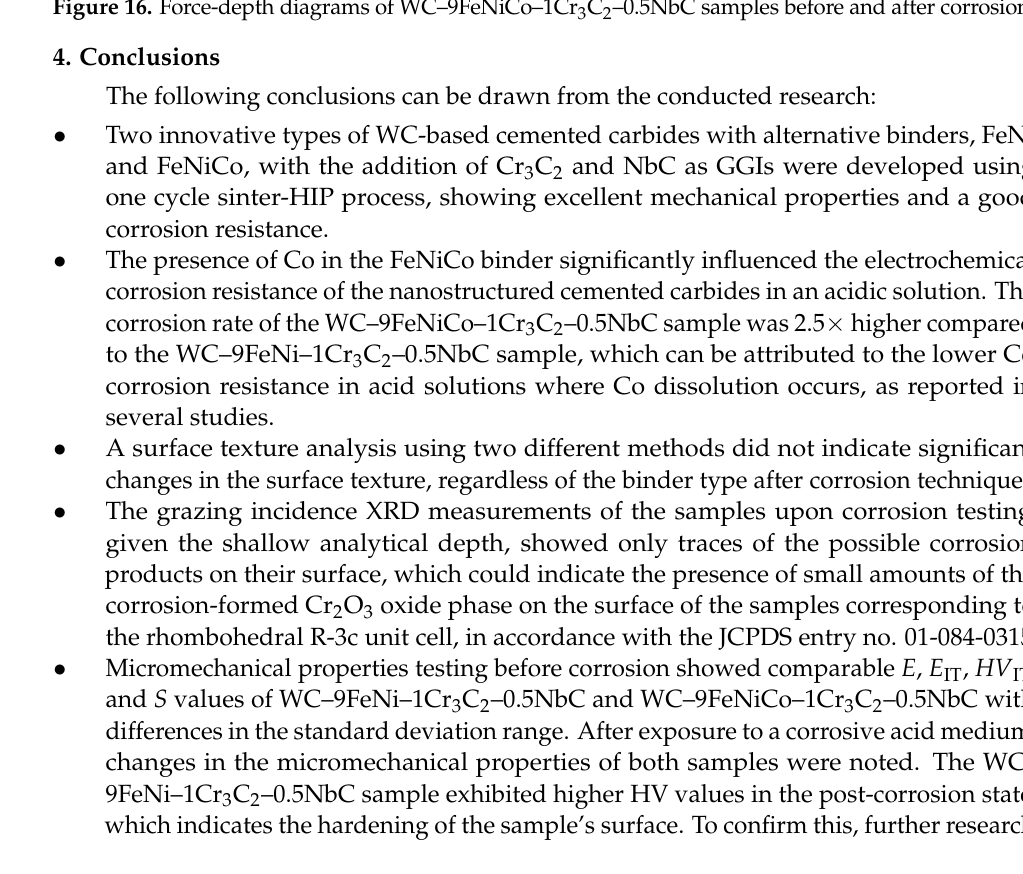
Figure 16. Force-depth diagrams of WC–9FeNiCo–1Cr 3 C 2 –0.5NbC samples before and after corrosion.